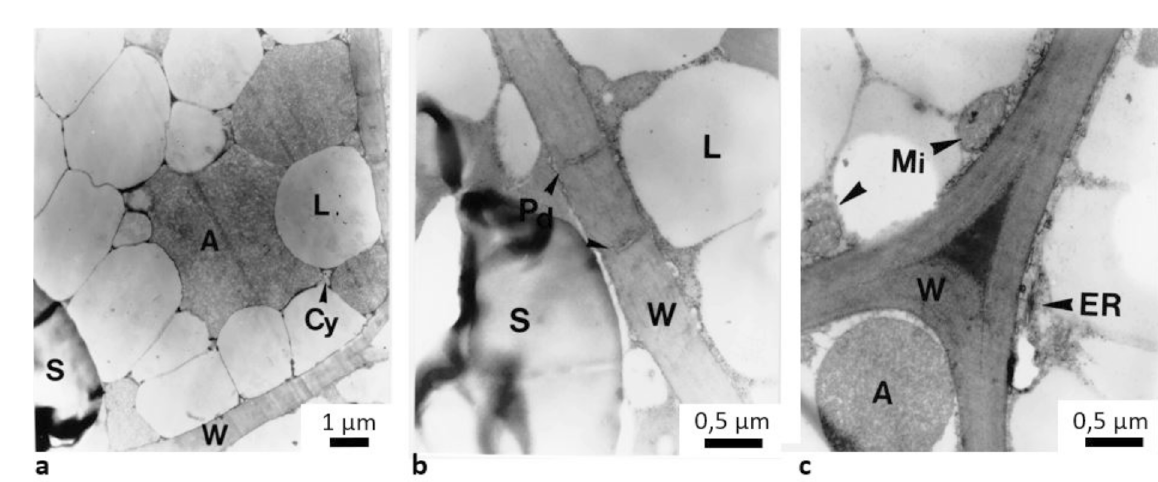
Fig. 6: Details of storage cells of T. cacao A: aleuron, S: starch grain, L: lipid vacuole, W: cell wall, ER: endoplasmatic reticulum, Mi: mitochondrion, Pd: plasmodesm, Cy: cytoplasma Ultra-thin